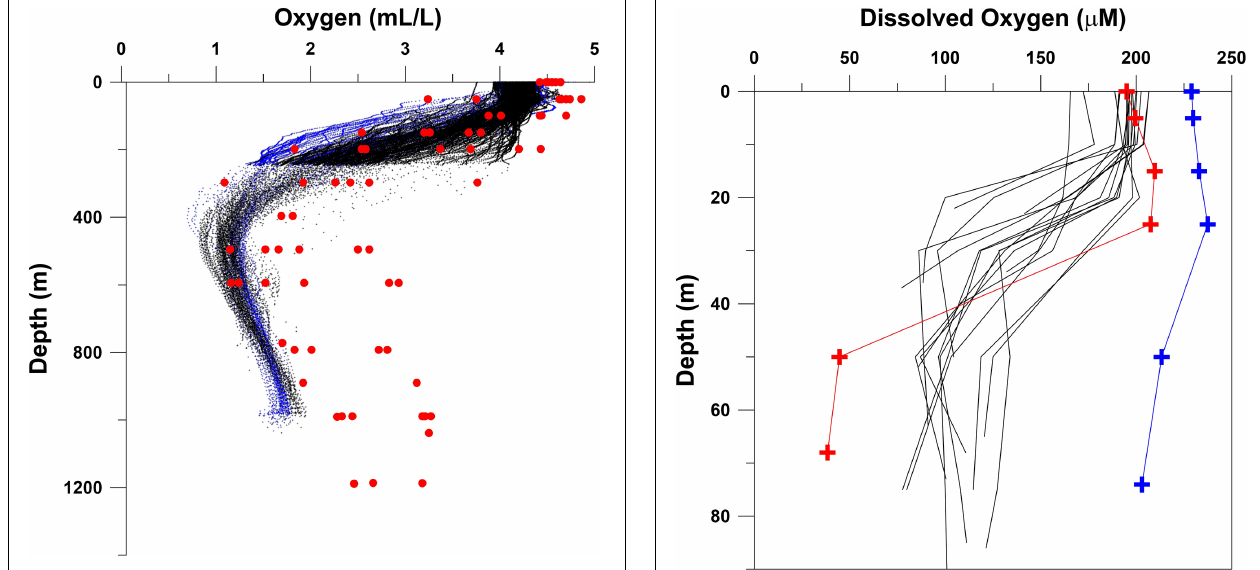
FIGURE 7 | Comparison of oxygen data in the Persian Gulf collected east of longitude 51.77 ◦ E during a cruise of R.V. Lesnoye in September 1968 (black profiles) with measurements made north of the Qatar peninsula during cruises of R.V. Mukhtabar al-Bahr in September–October 2000 (red symbols) and February–March 2001 (blue